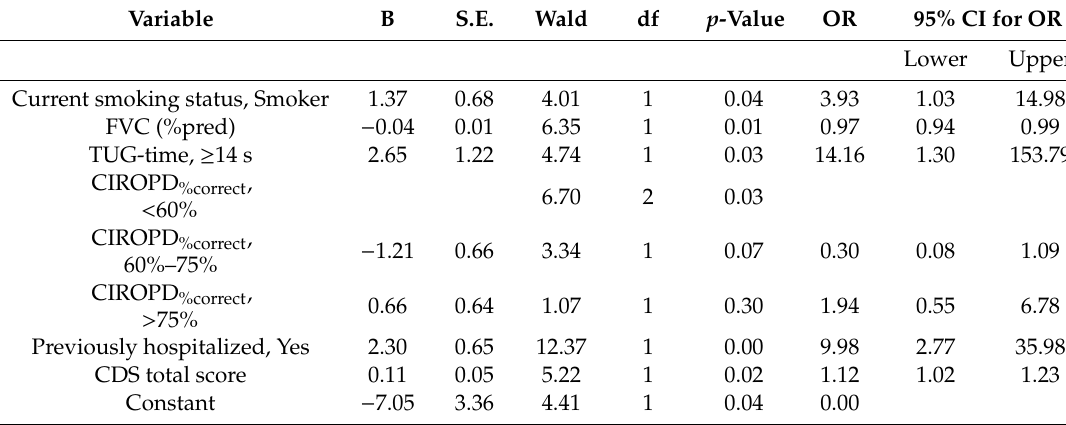
Logistic regression predicting the probability of eCOPD-related admission—overall prediction